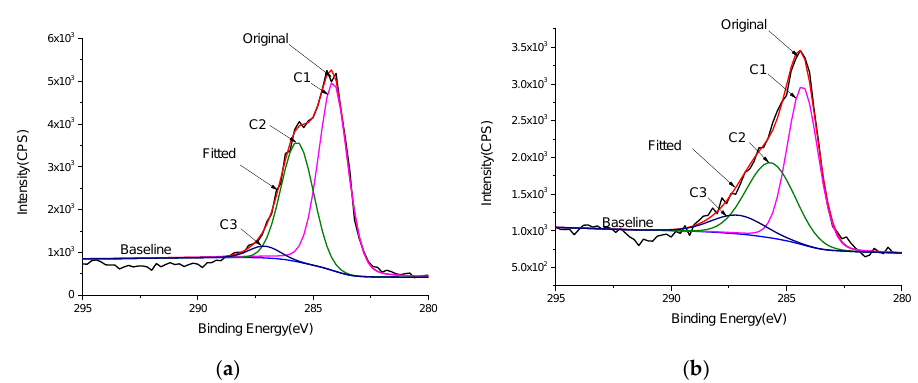
Figure 5. High-resolution XPS C 1s spectra: ( a ) un-sized basalt fabric (Basalt 1), and ( b ) plasma-treated basalt fabric (Basalt 11). Table 4. Atomic concentration (%) of the elemental surface composition and relative atomic concentration of carbon for basalt fabrics treated with plasma.